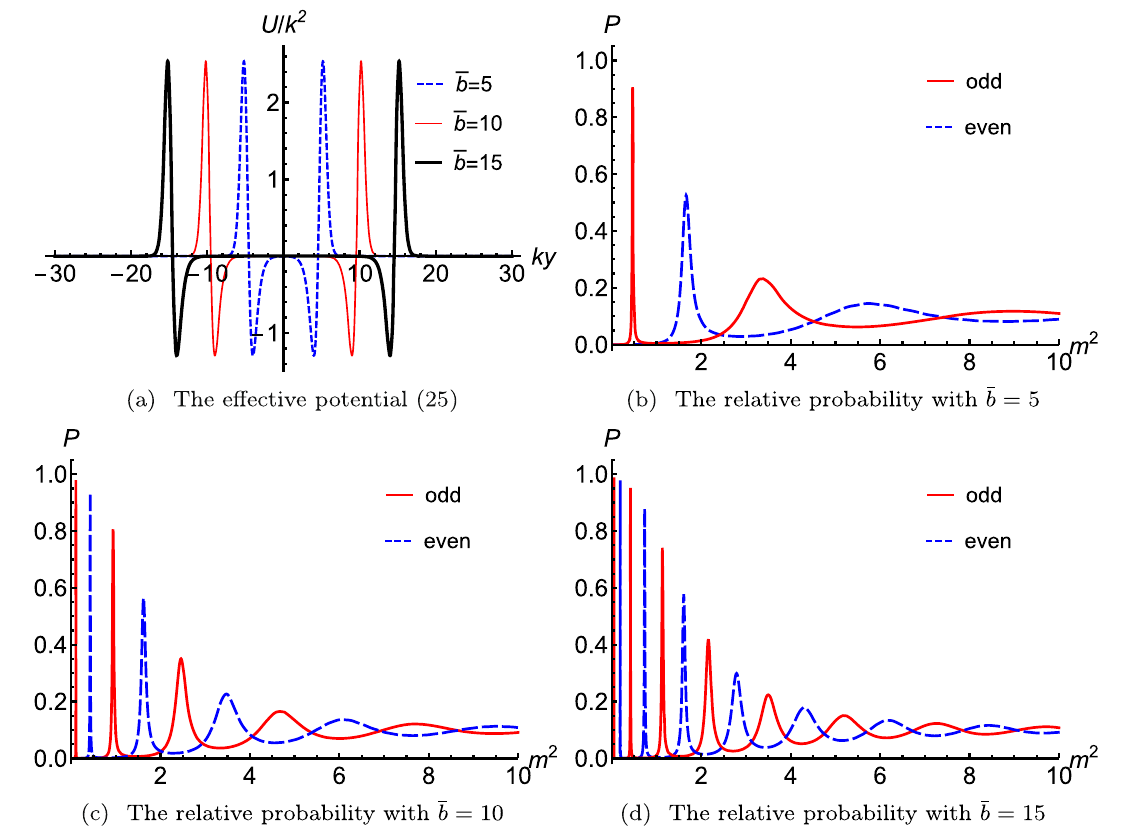
Fig. 2 The shapes of the effective potential (25) for different parameters ¯ b . The influence of the parameter ¯ b on the relative probability P for the odd-parity (red lines) and even-parity (blue dashed lines) massive KK modes. These figures are from Ref. [54]